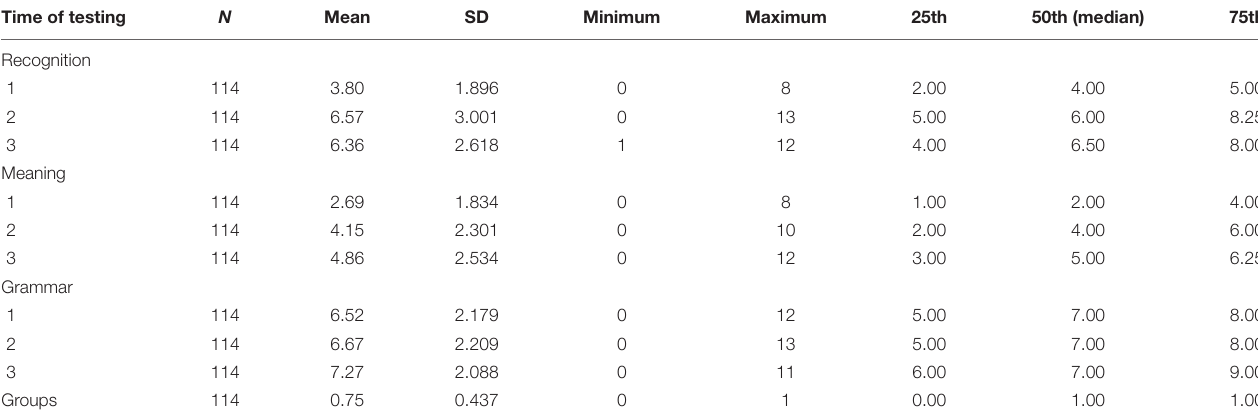
TABLE 4 | Descriptive statistics for vocabulary knowledge.